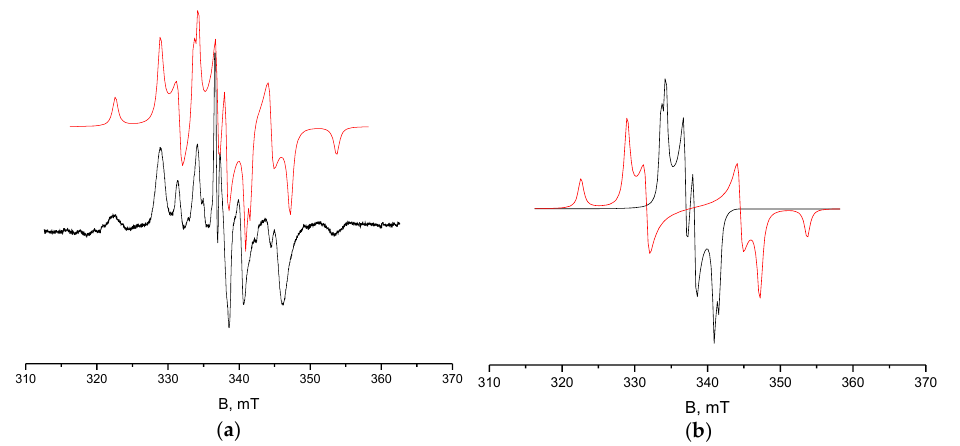
Figure 5. The ESR spectrum of diradical 9 in a diluted glassy solution: experiment and its modeling ( a ) and two components of the model spectrum ( b ).